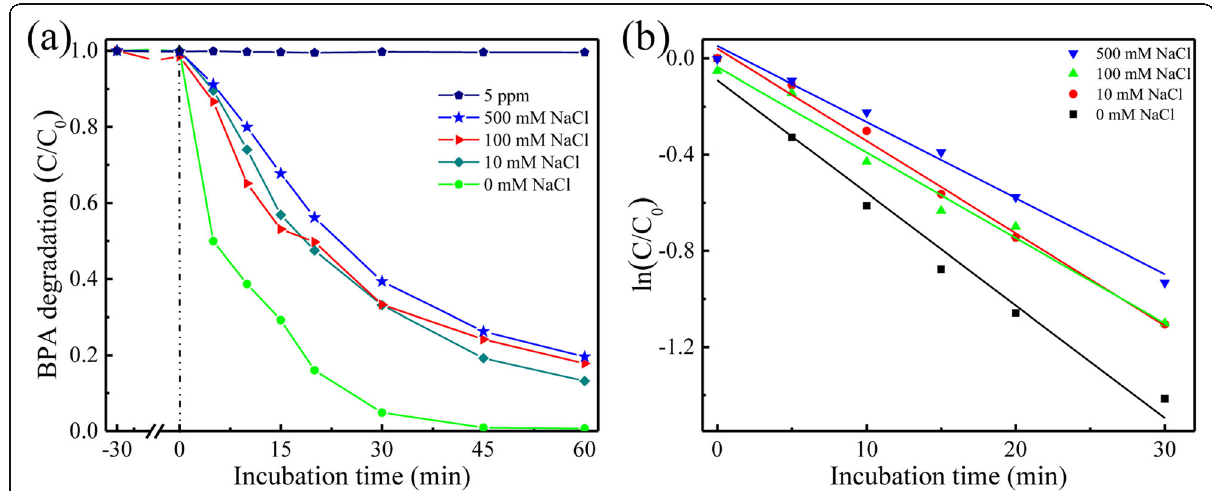
Fig. 4 ( a ) Effect of the NaCl concentration on the photocatalytic degradation of BPA with ZnO NPs under 365 nm UV light, ( b ) the plot of ln (C/ Co) vs irradiation time for the photocatalytic degradation of BPA with ZnO NPs under different NaCl